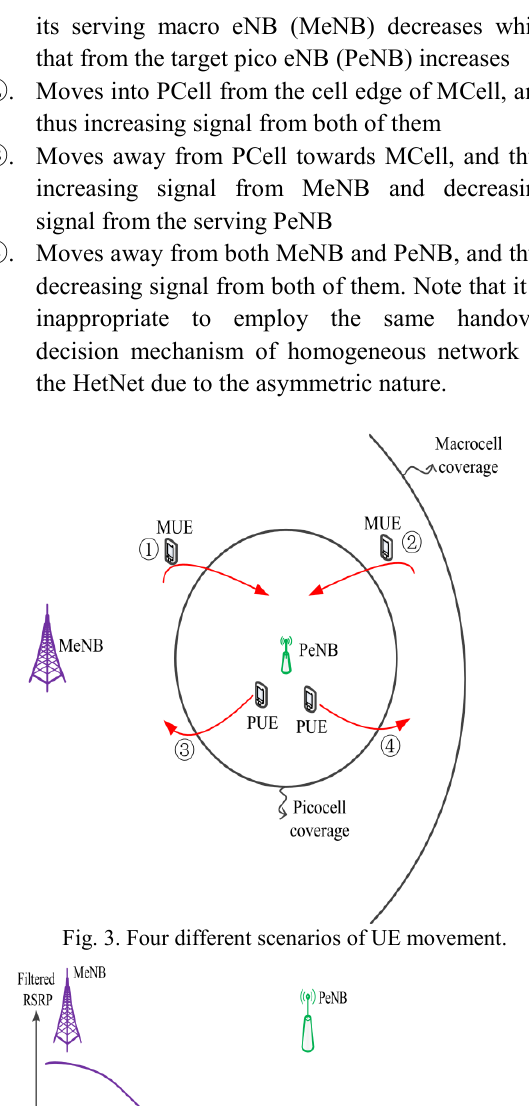
Fig. 3. Four different scenarios of UE movement.